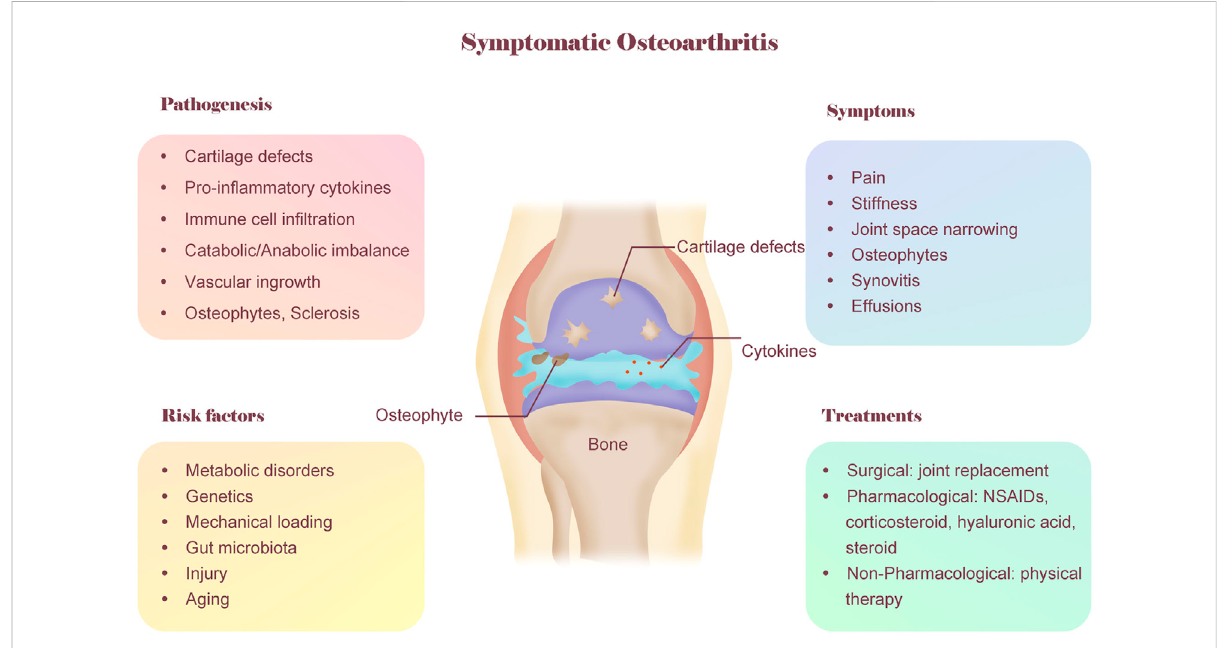
A conceptual model of OA including pathogenesis, symptoms, risk factors and treatments. OA is considered as a whole-organ disease and involves multiple factors. The typical symptoms of OA are pain and stiffness. The typical features of OA noted on radiographs include joint space narrowing and osteophytes. The pathogenesis of OA is complex, involving cartilage defects, in fl ammation, metabolic imbalance, etc. OA also involves multiple risk factors, including genetics, metabolic disorder, biomechanics, aging and gut microbiota. The current treatment for OA mainly include three categories: surgical, pharmacological, non-pharmacological. As a non-pharmacological treatment, physical therapy is promising for treating OA patients due to its cost-saving, convenience and few adverse